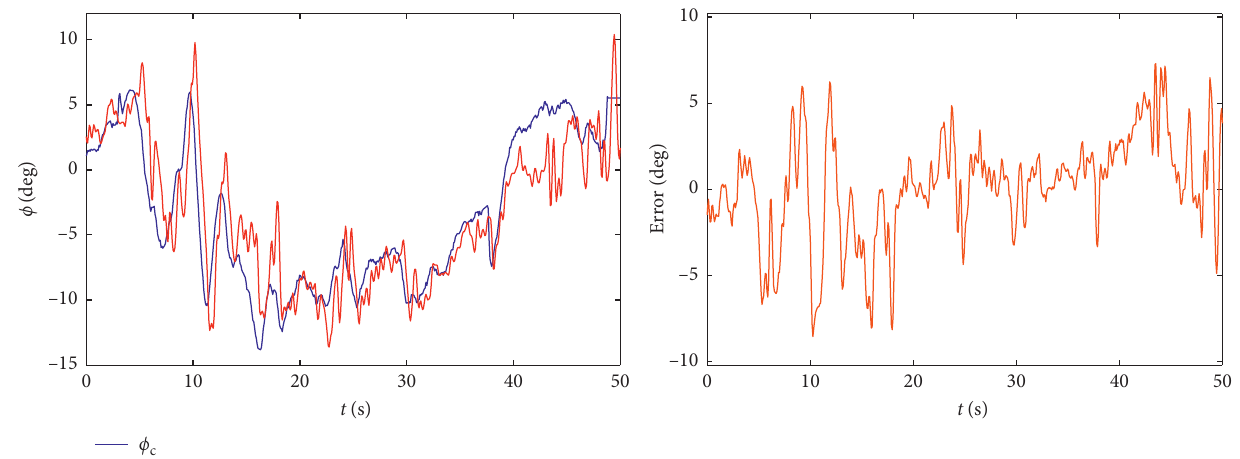
Figure 18: Roll control and tracking error of the RSLQR controller without ESO.